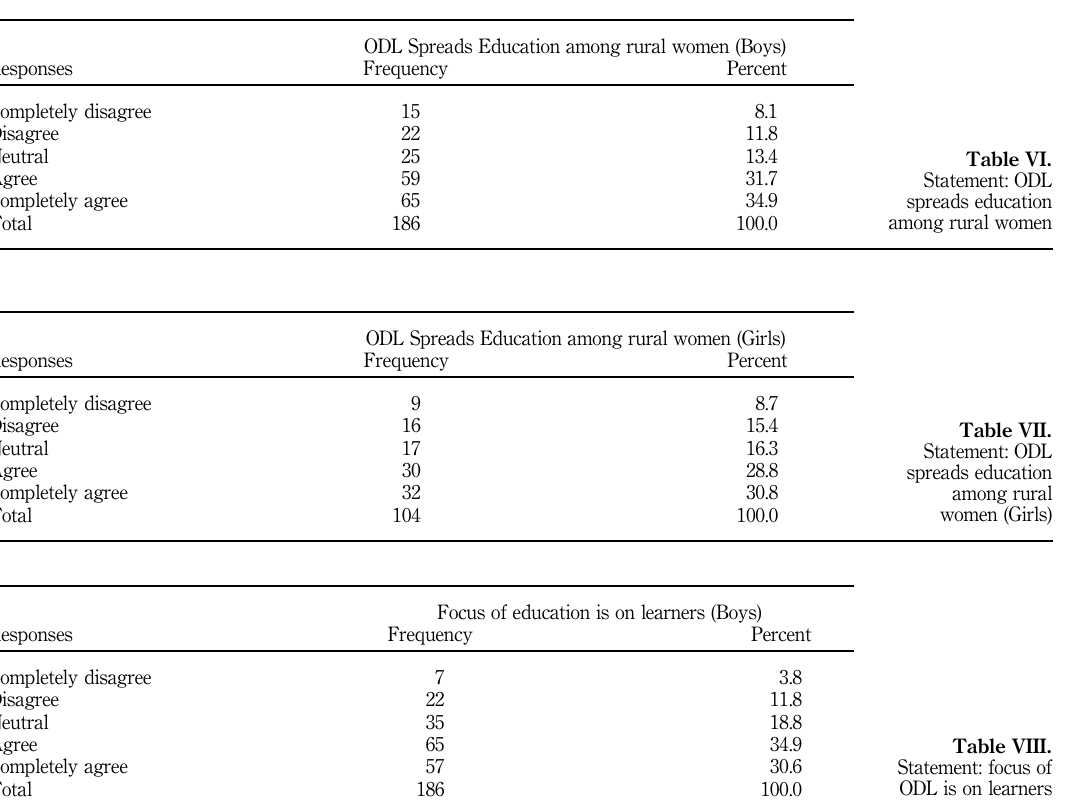
Table VIII. Statement: focus